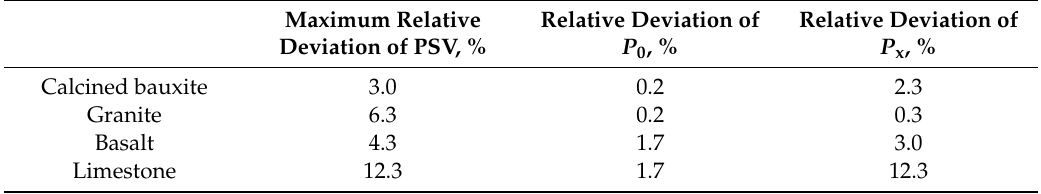
Fig. 6 Modeled and tested PSV results for basalt.